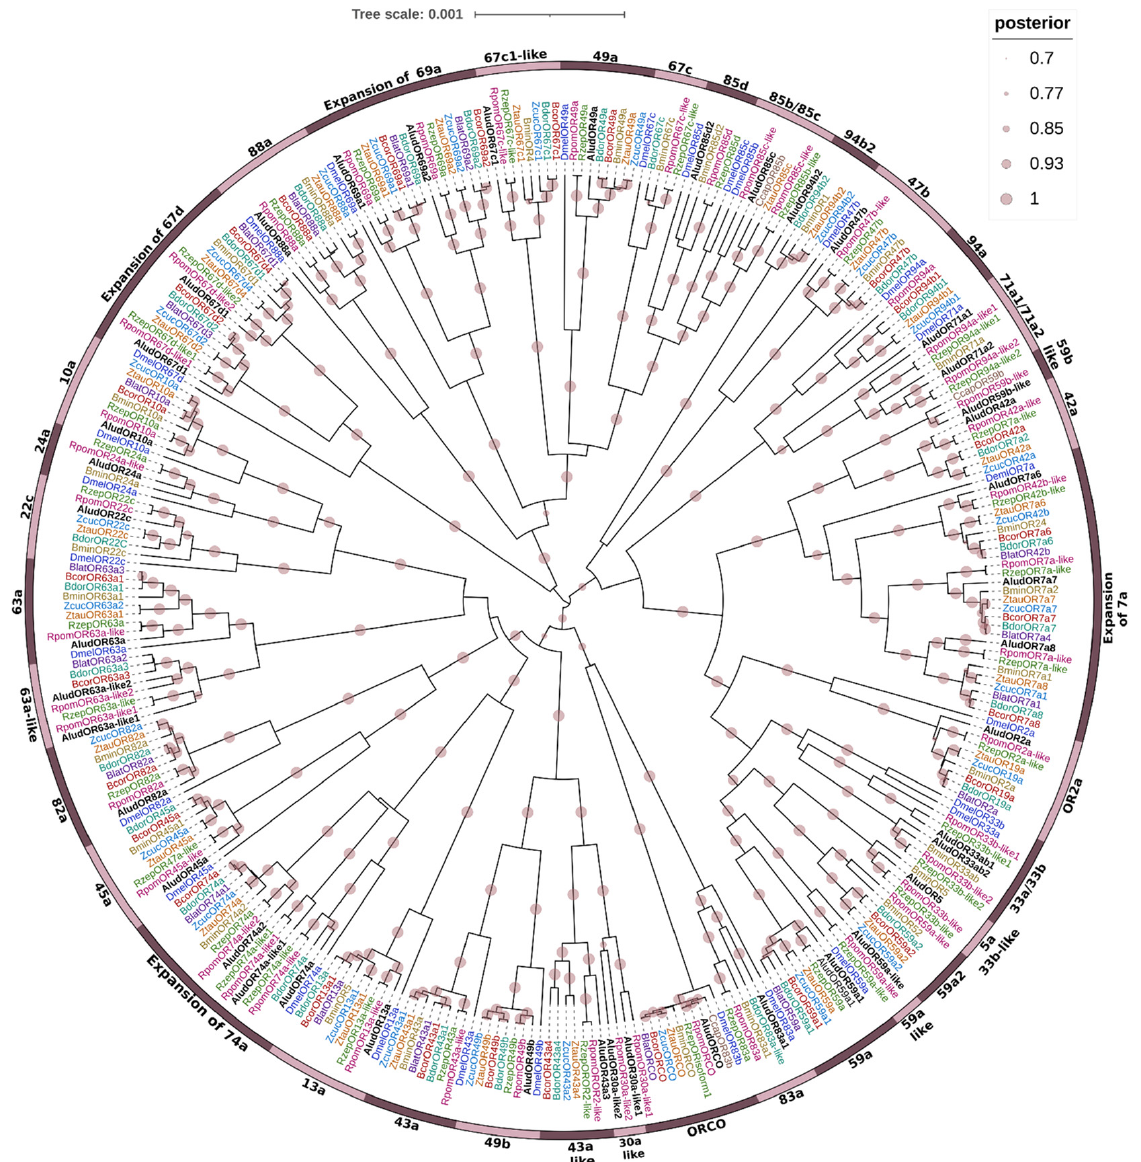
Figure 5. Bayesian phylogenetic analysis of candidate ORs of Anastrepha ludens with homologs from eight dipteran species and the model organism Drosophila melanogaster . Circles showed posterior probability values higher than 70%. Pink bars delimit clusters of AludORs and their orthologues.